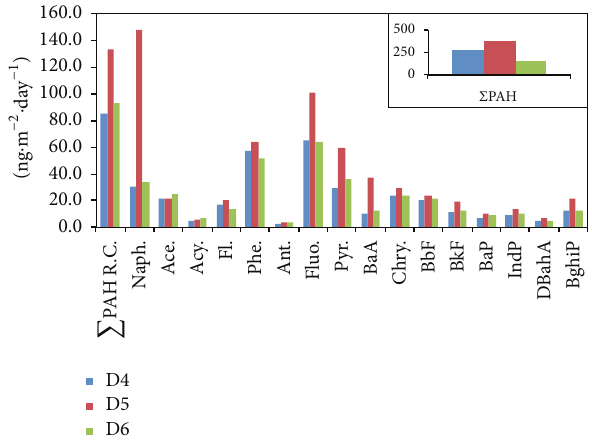
Figure 15: Average depositions of organic micropollutants for deposimeters D4, D5, and D6 from September 2006 to March 2009. Total IPA concentrations are reported separately because of different scale.